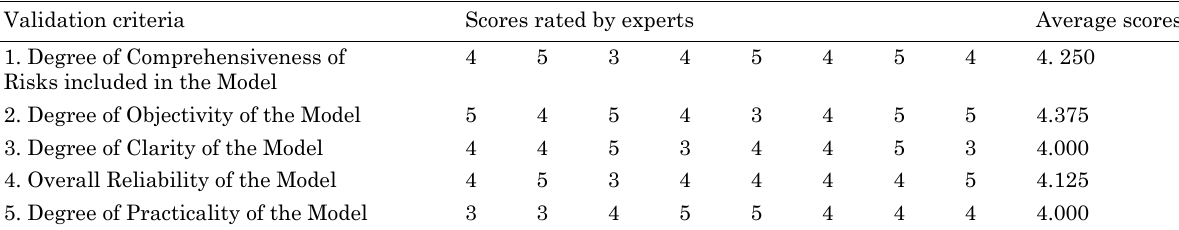
Table 12. Results of validation exercise for FANP risk allocation model Validation